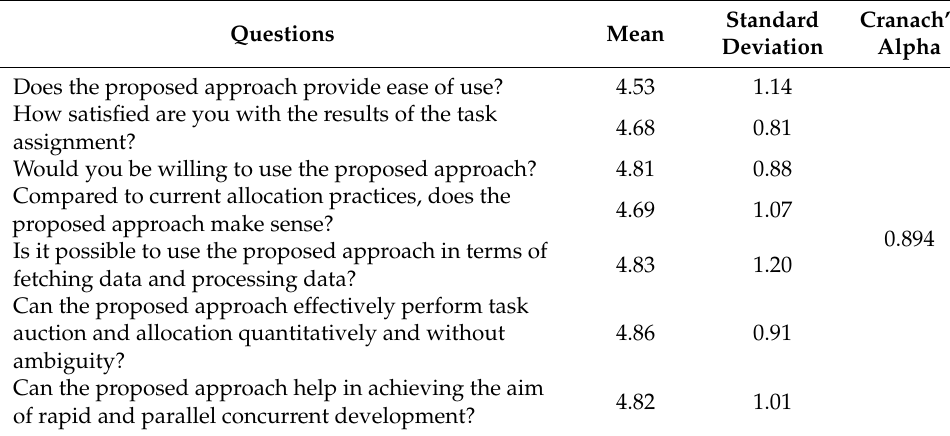
Table 2. Summary of reliability analysis of survey